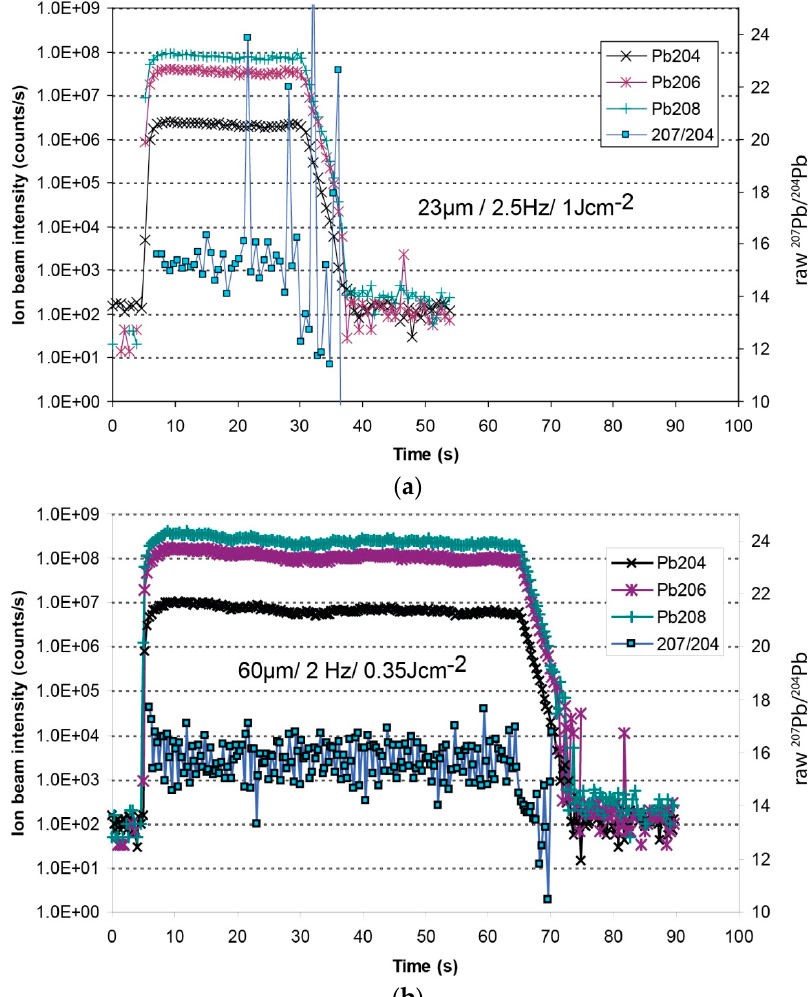
Figure 4. Comparison of results of different ablation condition of galena: ( a ) 23 µm, 2.5 Hz, and 1 J·cm − 2 ; and ( b ) 60 µm, 2 Hz, and 0.35 J·cm − 2 .